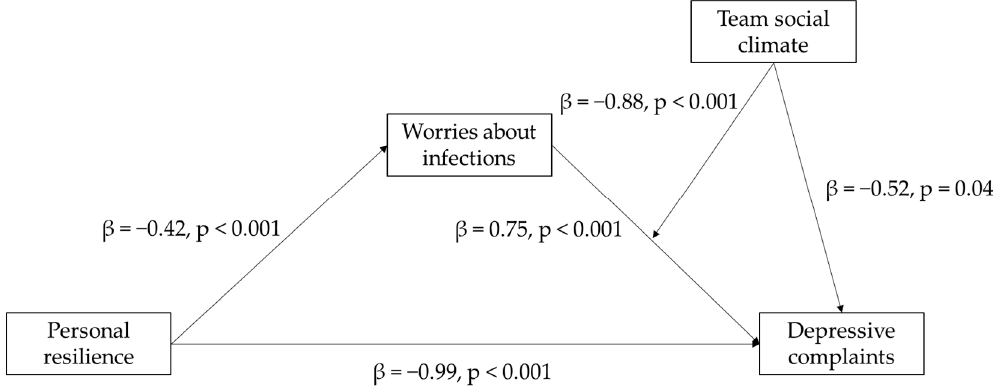
Figure 1. Moderated mediation model for the effect of personal resilience via worries about infections as moderated by team social climate .